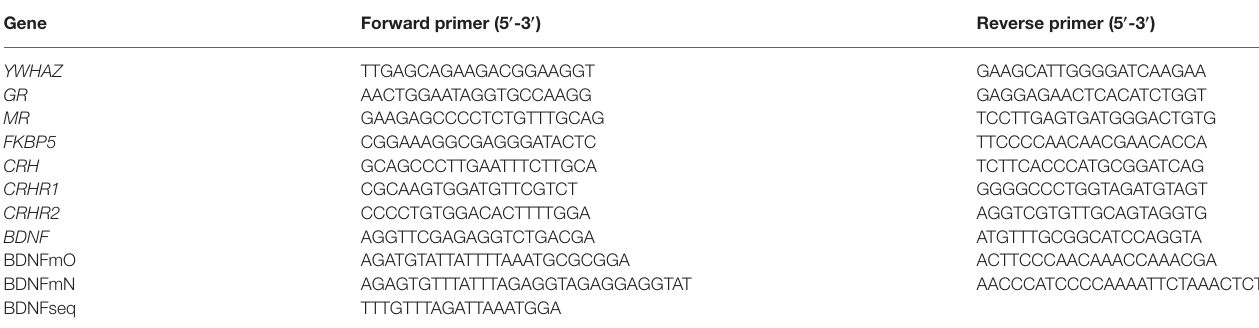
TABLE 1 | Primer sequences